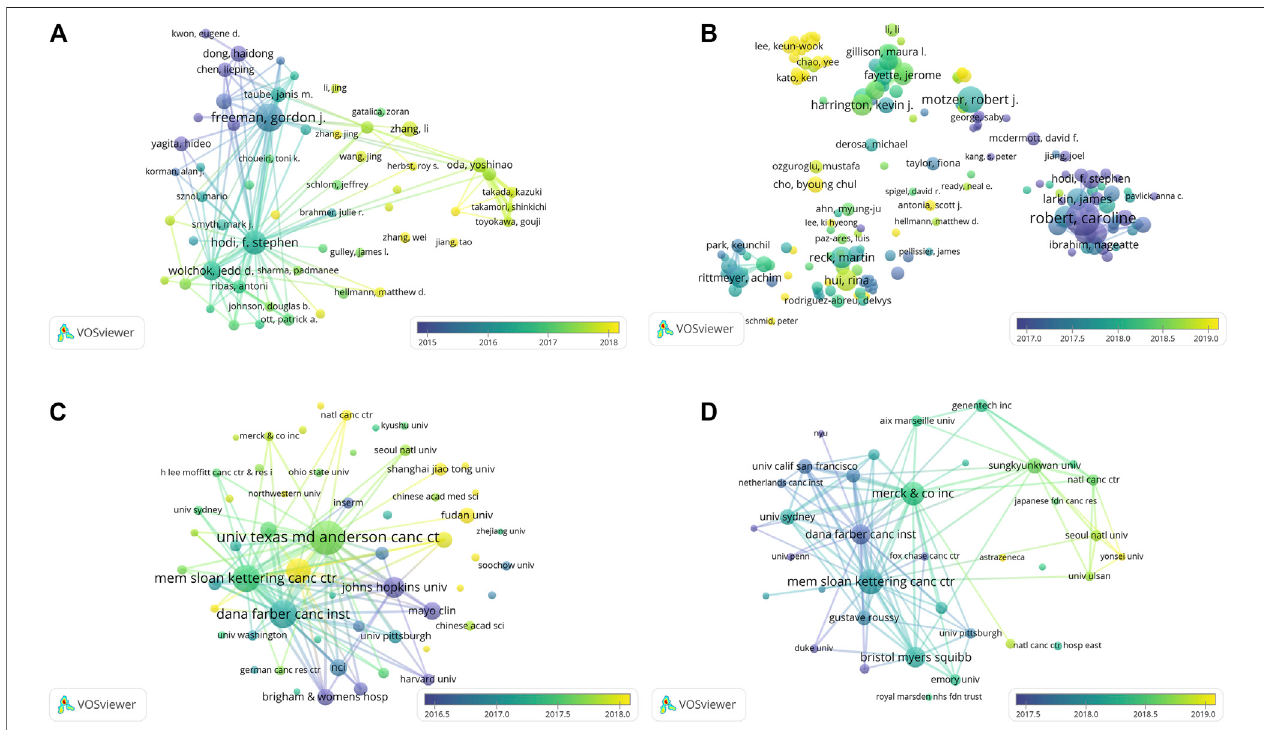
FIGURE 5 | The overlay visualization map of author and institution coupling analyses. Author coupling analysis (A) and institution coupling analysis (C) for work on the PD1/PDL1 molecule. Author coupling analysis (B) and institution coupling analysis (D) in RCT of anti-PD1/PDL1.